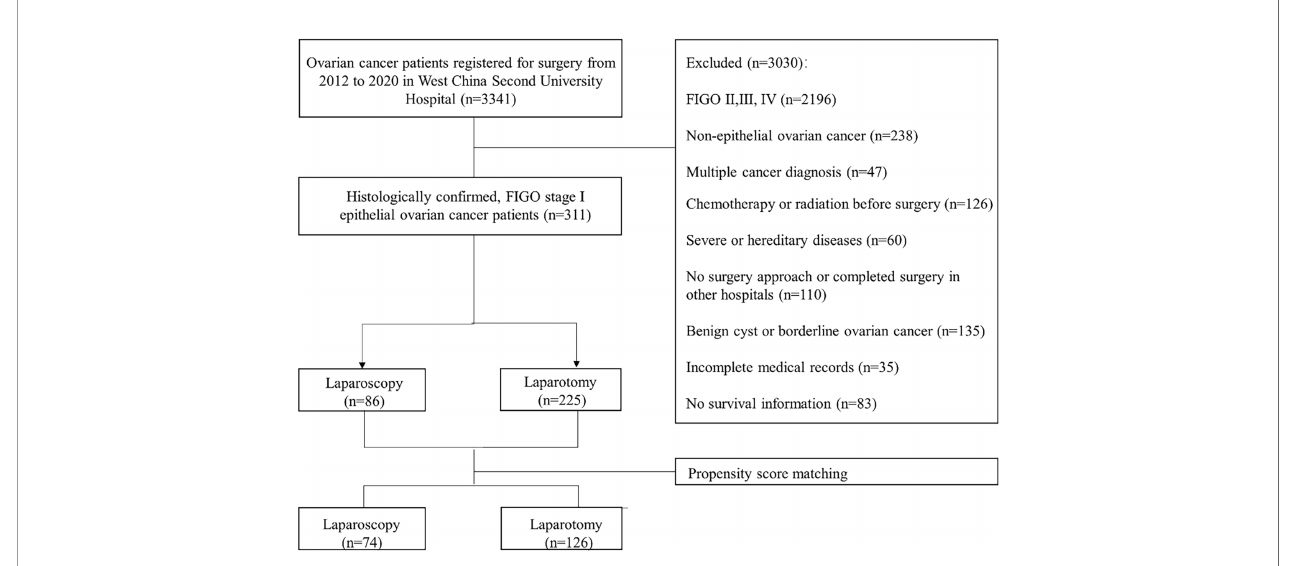
FIGURE 1 | Flow chart of patients ’